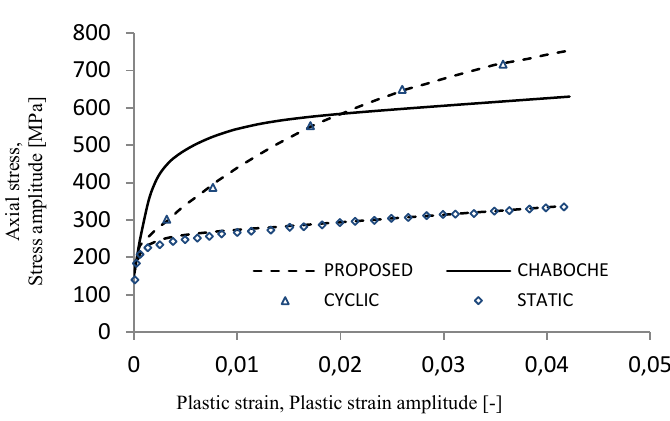
Figure 3. Prediction of static and cyclic uniaxial stress–strain curves; the experimental data for SS304 were reproduced from